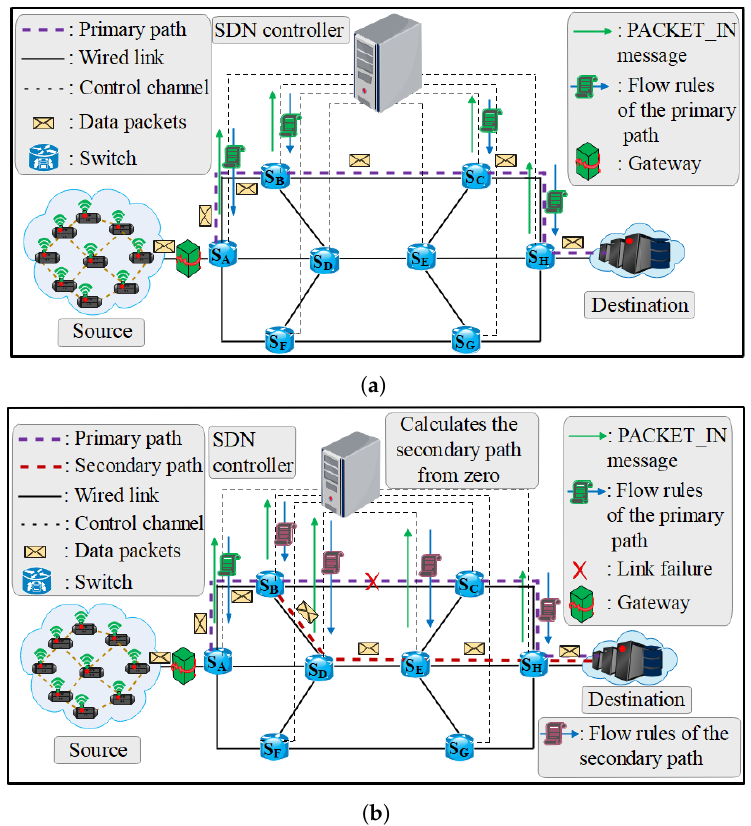
Figure 1. Example of Local Restoration (LR) application for the SDN platform. ( a ) Before an intermediate link S B → S C failure. ( b ) After an intermediate link S B → S C